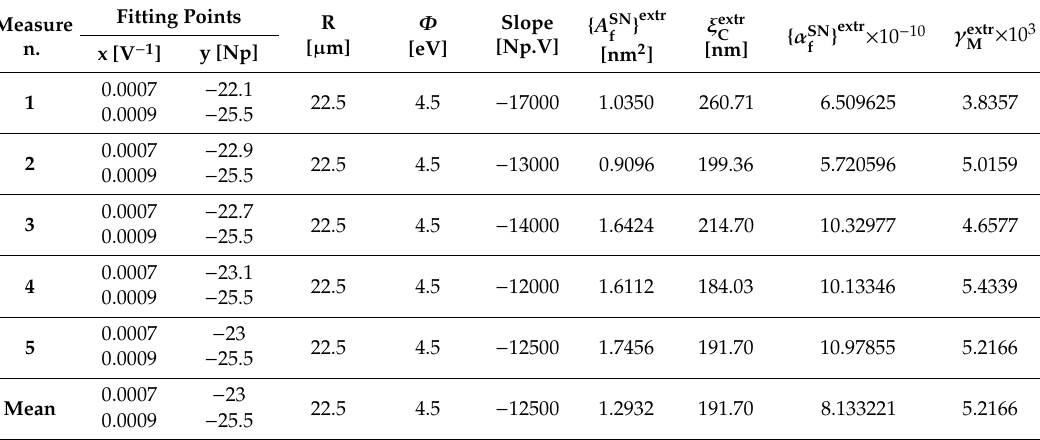
Figure 8. Calculation of the macroscopic area. For the illustration, the HB polymer graphite (PG) rod image was used.